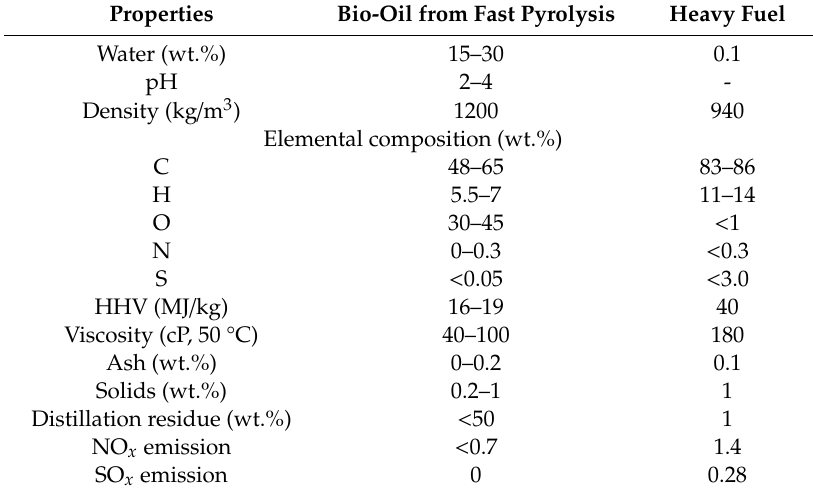
Table 4. The major physiochemical properties of bio-oil obtained from fast pyrolysis [27].